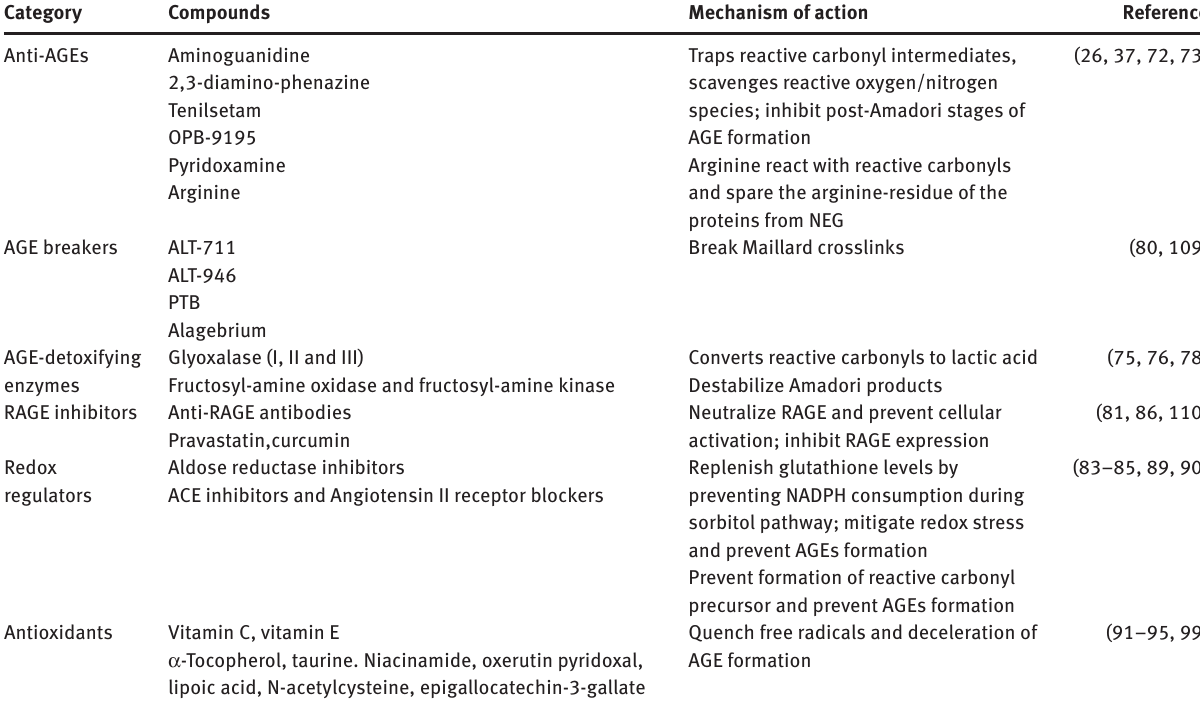
Table 2: List of various anti-AGE compounds that are employed to inhibit or decelerate AGE formation, destabilize preformed AGEs and regulate AGE receptor